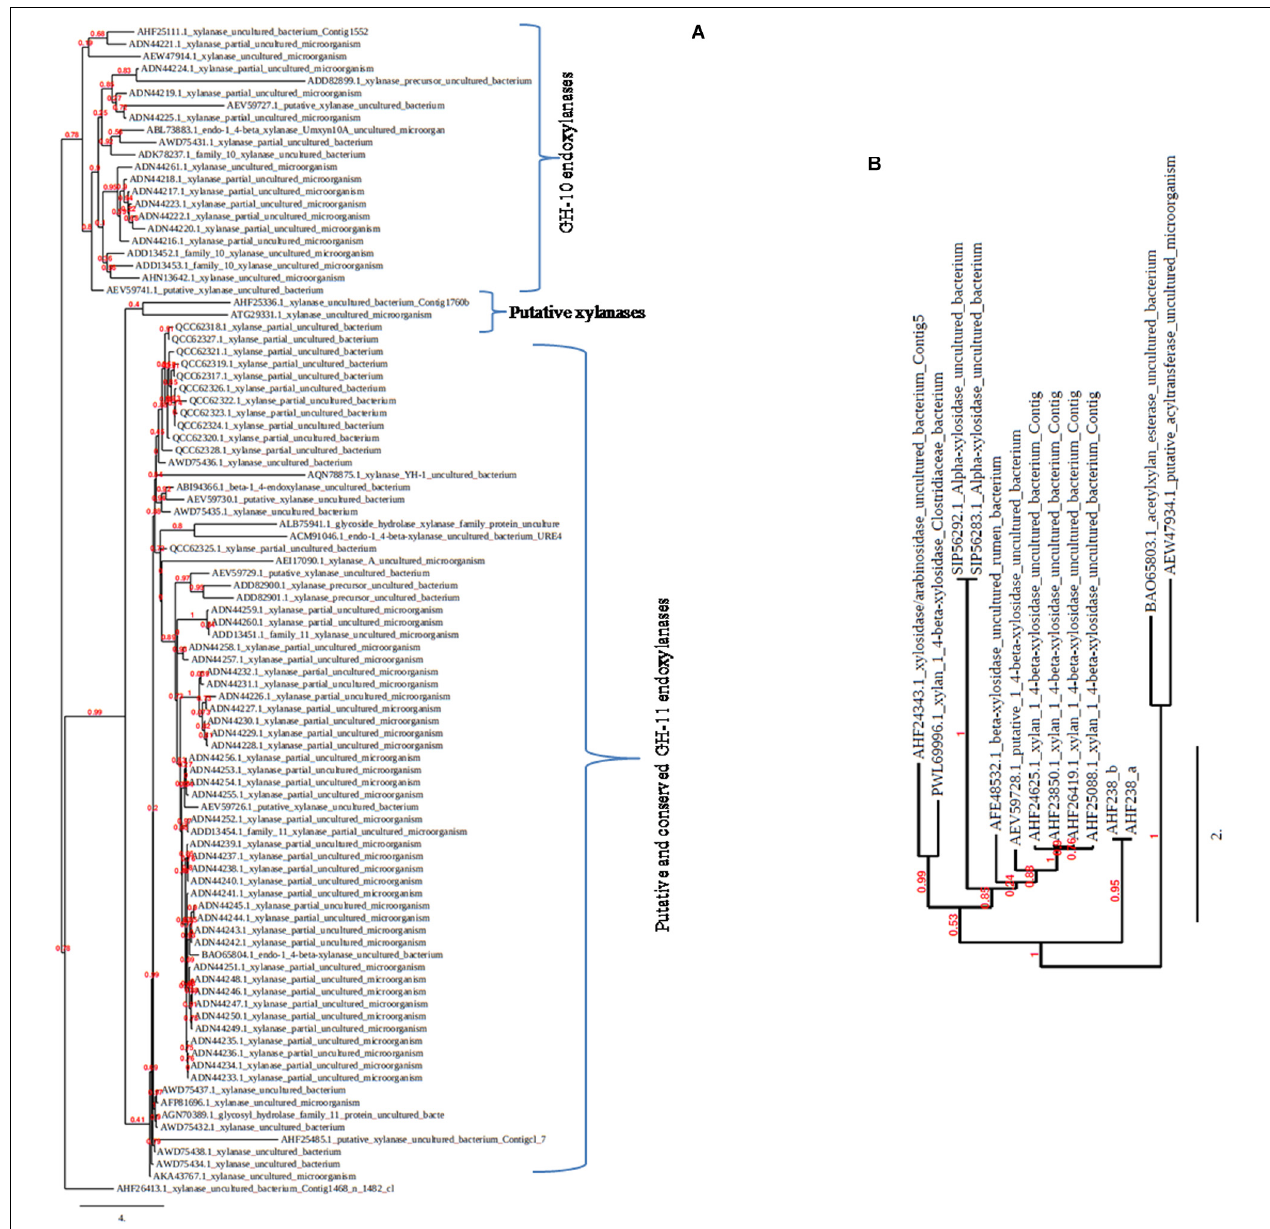
FIGURE 2 | The phylogenetic trees showing the diversity among metagenomic xylanolytic enzymes. The trees ( A: GH-10 and GH-11 xylanases; B: xylanolytic enzymes other than GH-10 and GH-11 xylanases) were constructed by including the protein sequences (complete/partial) available in the NCBI database using the keyword xylanase/xylosidase/arabinofuranosidase/acetyltransferase from uncultured